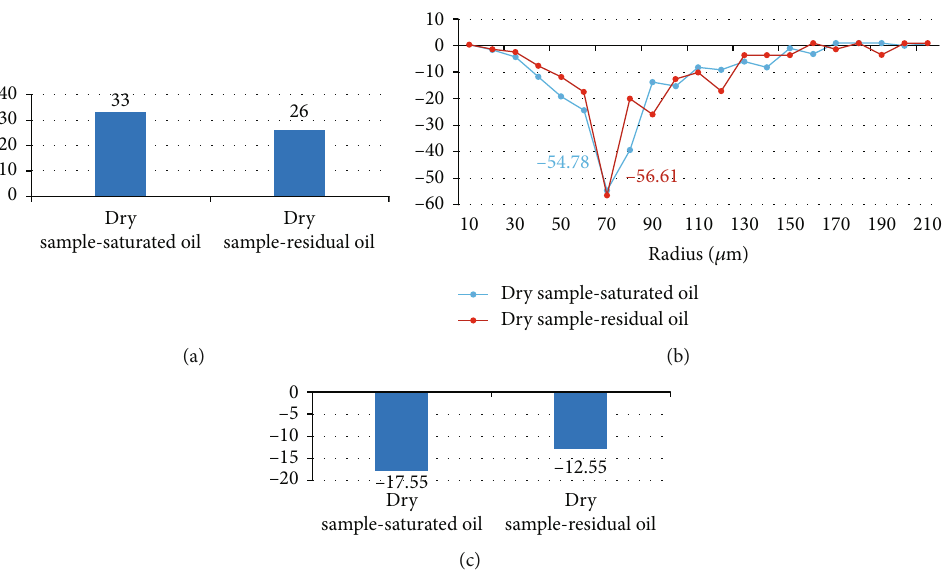
Figure 7: Water fl ooding evaluation results by curve similarity: (a) results of overall trend, (b) results of retractility, and (c) results of